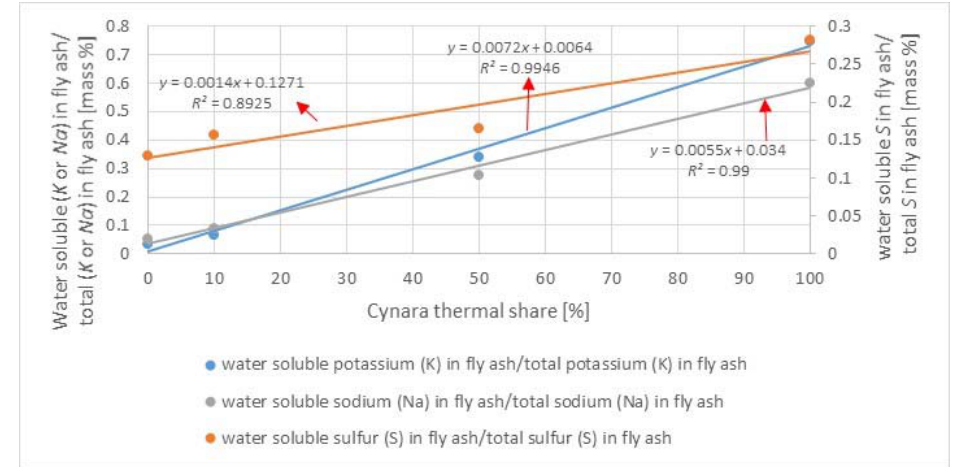
Figure 8. The ratio of water soluble S in the fly ash to total S in the fly ash and the ratio of water soluble alkali (K and Na) in the fly ash to total alkali (K and Na) in the fly ash as a function of the thermal share of Cynara in the fuel blend.